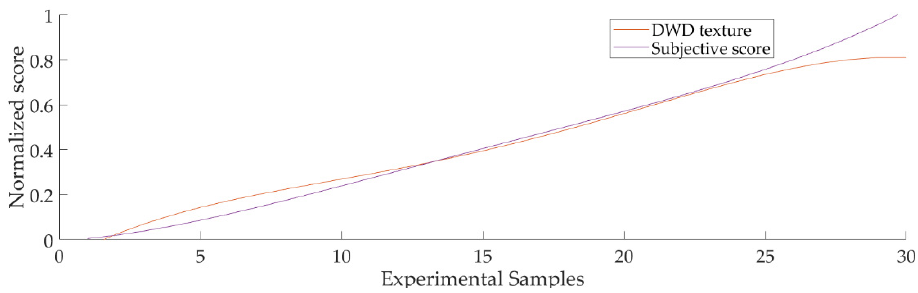
Figure 7. The fitting curves of the subjective score and the dynamic weight dispatch (DWD) texture.